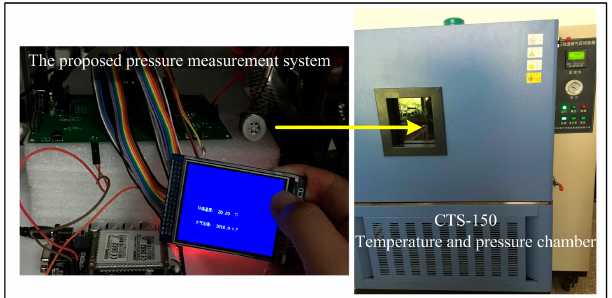
Figure 10. Photographs of the proposed SiNW pressure measurement system and calibration and test experimental setup. The CTS-150 constant temperature and pressure chamber is manufactured by Cliphyco Instruments Co., Limited (Hong Kong,